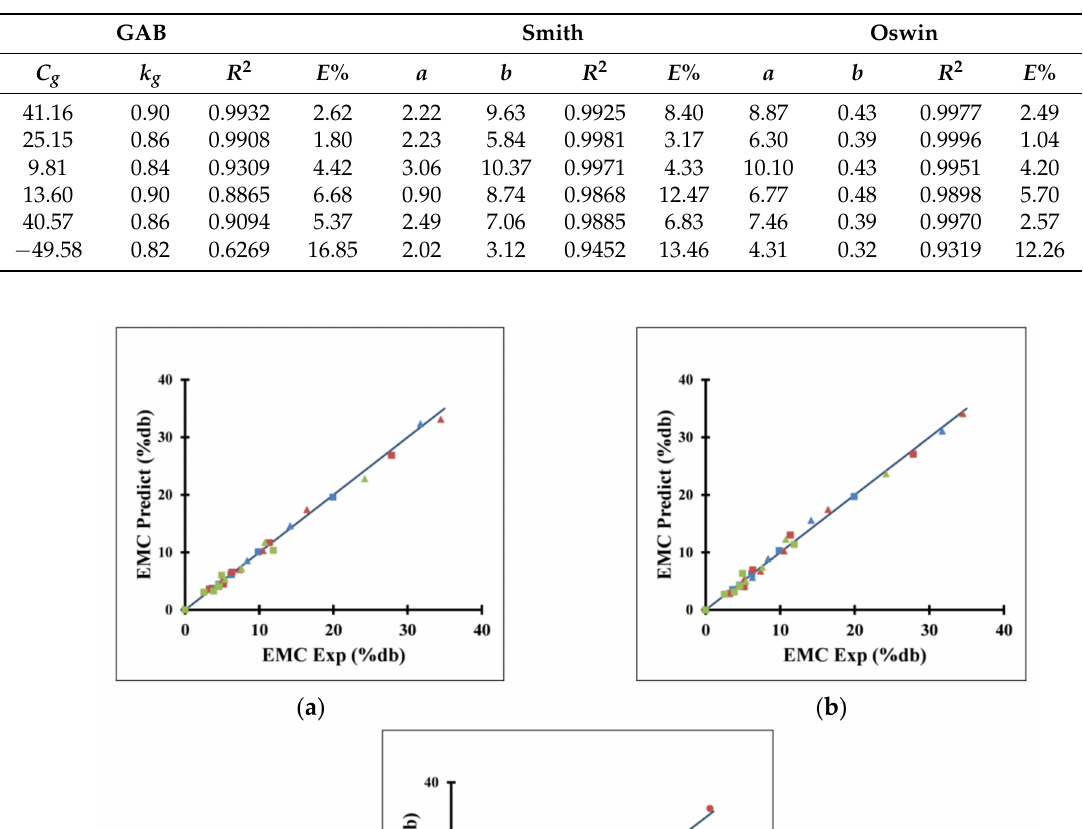
Table 5. Moisture adsorption parameter for raw and torrefied biomass.